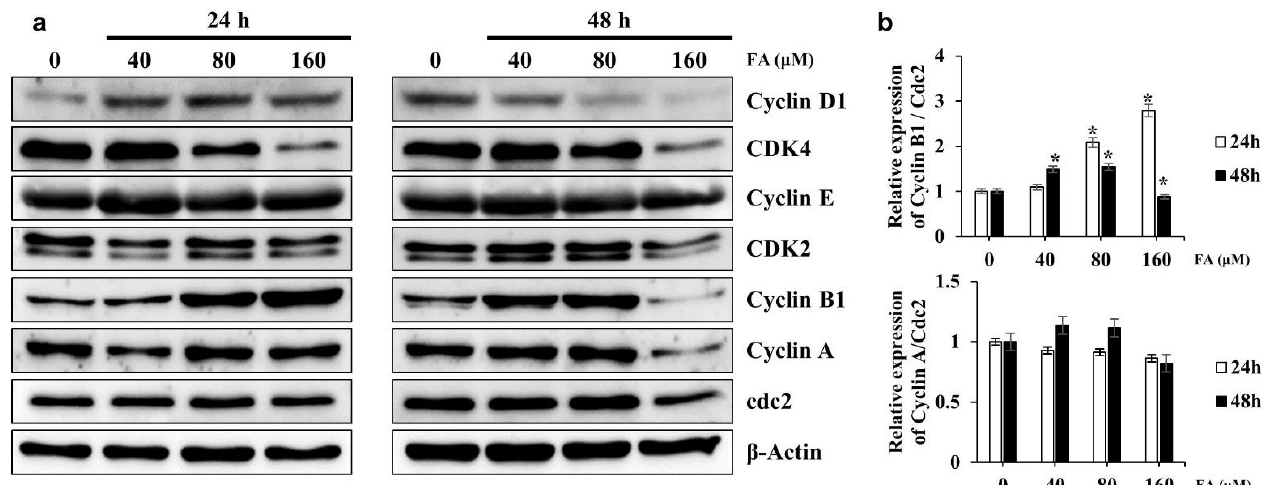
Figure 3. Effect of farrerol (FA) on cell cycle regulatory proteins in SKOV3 cells. ( a ) SKOV3 cells were treated with FA (0, 40, 80, or 160 μM) for 24 or 48 h and then harvested. The cell lysates were prepared, subjected to SDS -PAGE, and analyzed by Western blotting. The expression of Cyclin D1, CDK4, Cyclin E1, CDK2, Cyclin B1, Cyclin A, and Cdc2 was determined; the expression of β -actin was used to verify equal loading of the samples. ( b ) Representative image of the Western blots. Data are means ± standard deviation from three independent experiments (*, p < 0.05).